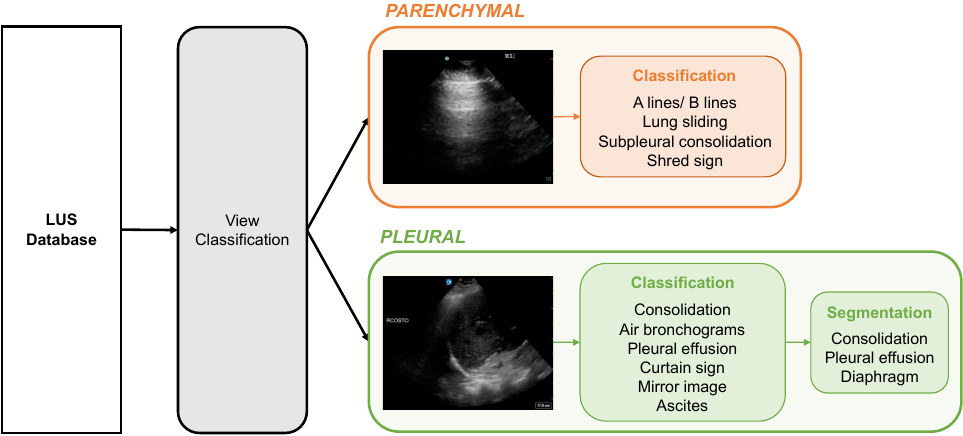
Figure 1. Summary of the hierarchical annotation workflow. LUS classification tasks are view-specific. Automation of the view classification step separates LUS clips. Further, segmentation tasks can subsequently be stratified by